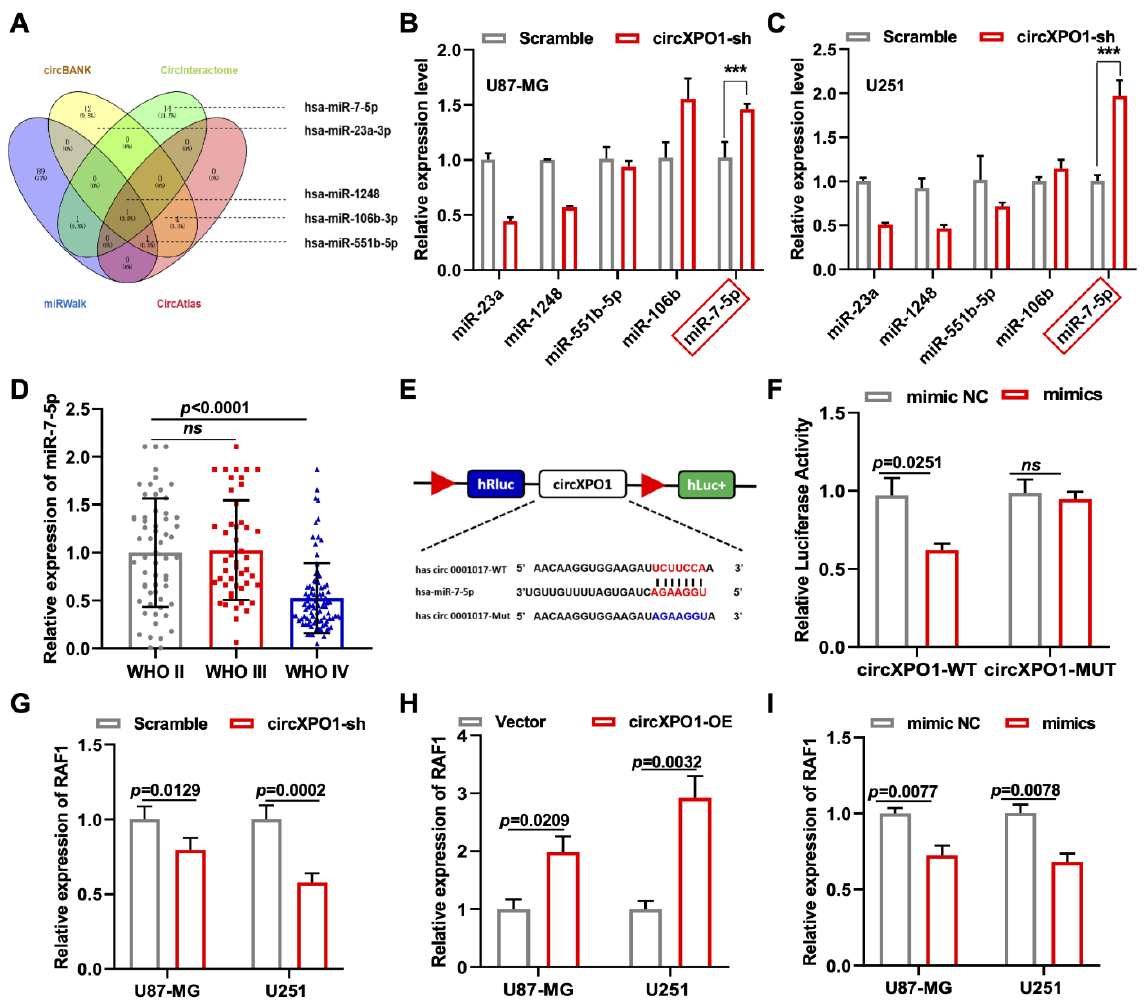
Figure 4. Identification of miR-7-5p as circXPO1 target. ( A ) Venn diagram exhibits the screening of circXPO1-targeted miRNA candidates. ( B , C ) The miR-7-5p was selected due to its rise in levels with the circXPO1 knockdown. “***” indicates p < 0.001. ( D ) Decreased expression of miR-7-5p with tumor grade was demonstrated with CGGA data. ( E ) Putative binding site of miR-7-5p